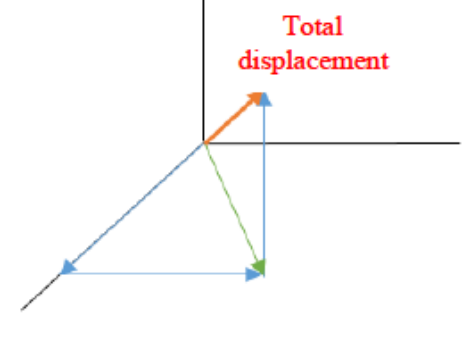
Figure 4: The total displacement of sequential motion